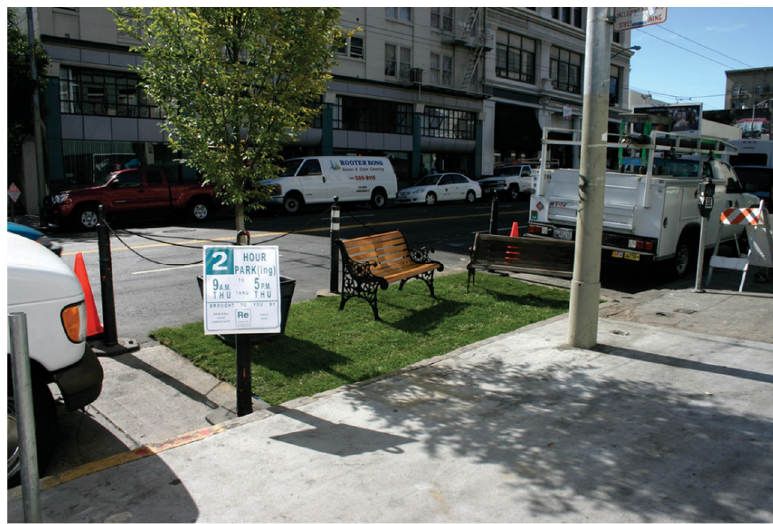
Figure 1. One of several Park(ing) Day parks that were set up in San Francisco by Rebar Group during the first official edition of the event (2006). Photo by Rebar (Creative Commons By licence).